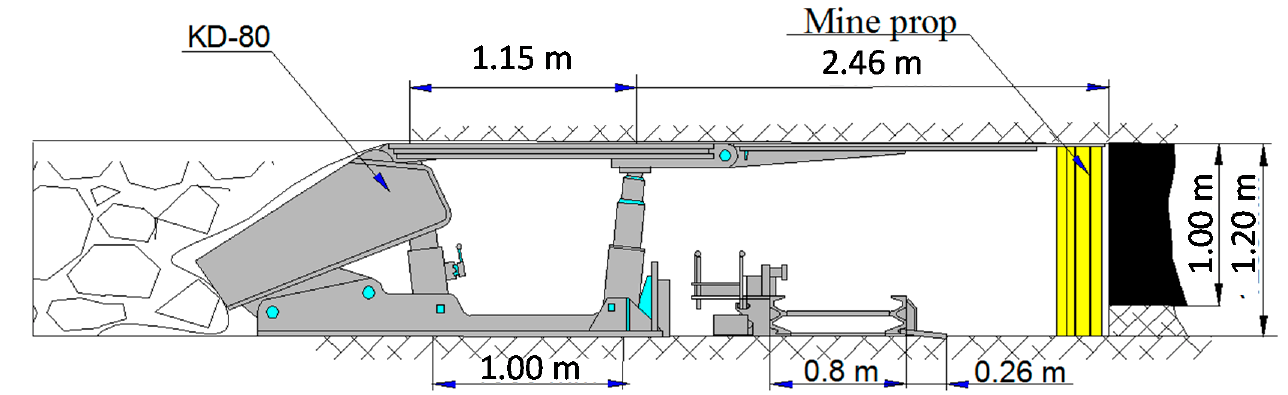
Figure 7. Structural elimination of the drawbacks of a powered support and increase in its bearing capacity.